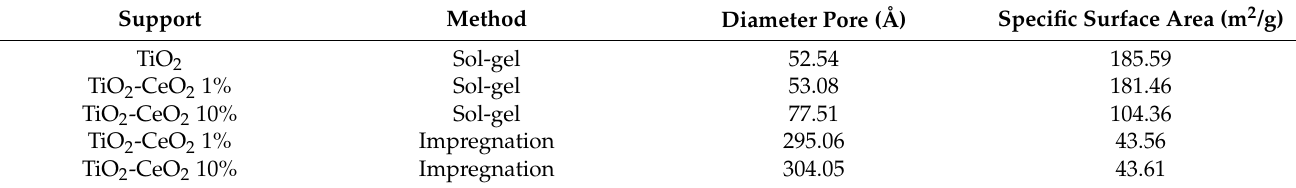
Table 1. Specific surface area, and pore diameter for TiO 2 -CeO 2 catalysts